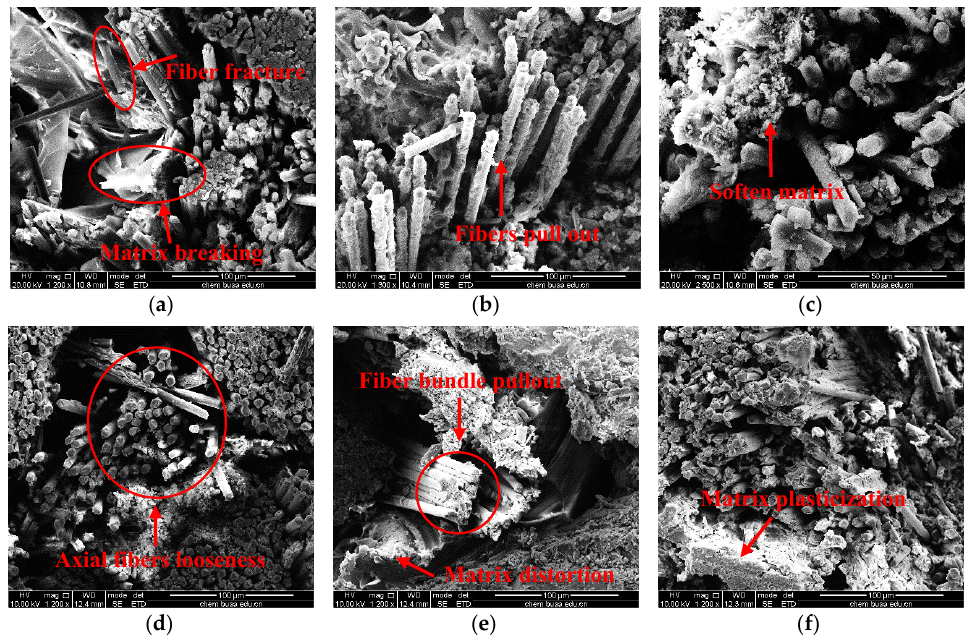
Figure 8. Scanning electron microscopy (SEM) photographs of specimens with 21° braiding angle at different temperatures: ( a ) 25 °C, ( b ) 60 °C, ( c ) 90 °C, ( d ) 120 °C, ( e ) 150 °C, and ( f ) 180 °C.